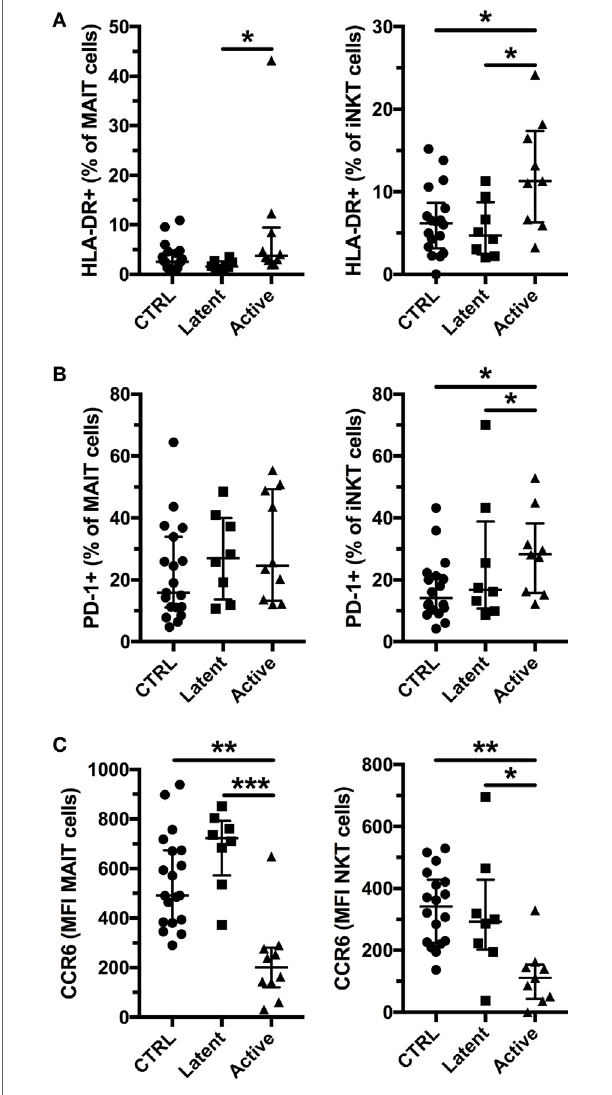
FigUre 2 | Invariant natural killer T (iNKT) cells express activation and exhaustion markers together with reduced CCR6 expression in active tuberculosis. Expression of HLA-DR by mucosal-associated invariant T (MAIT) and iNKT cells (a) , expression of PD-1 by MAIT and iNKT cells (b) , and levels of CCR6 expression by MAIT and iNKT cells (c) according to their Mycobacterium tuberculosis infection status (controls n = 19, latent n = 8, and active n = 10 for MAIT cells and n = 9 for iNKT cells). The lines and whiskers represent the median and interquartile range, respectively (* p < 0.05, ** p < 0.01, and *** p <